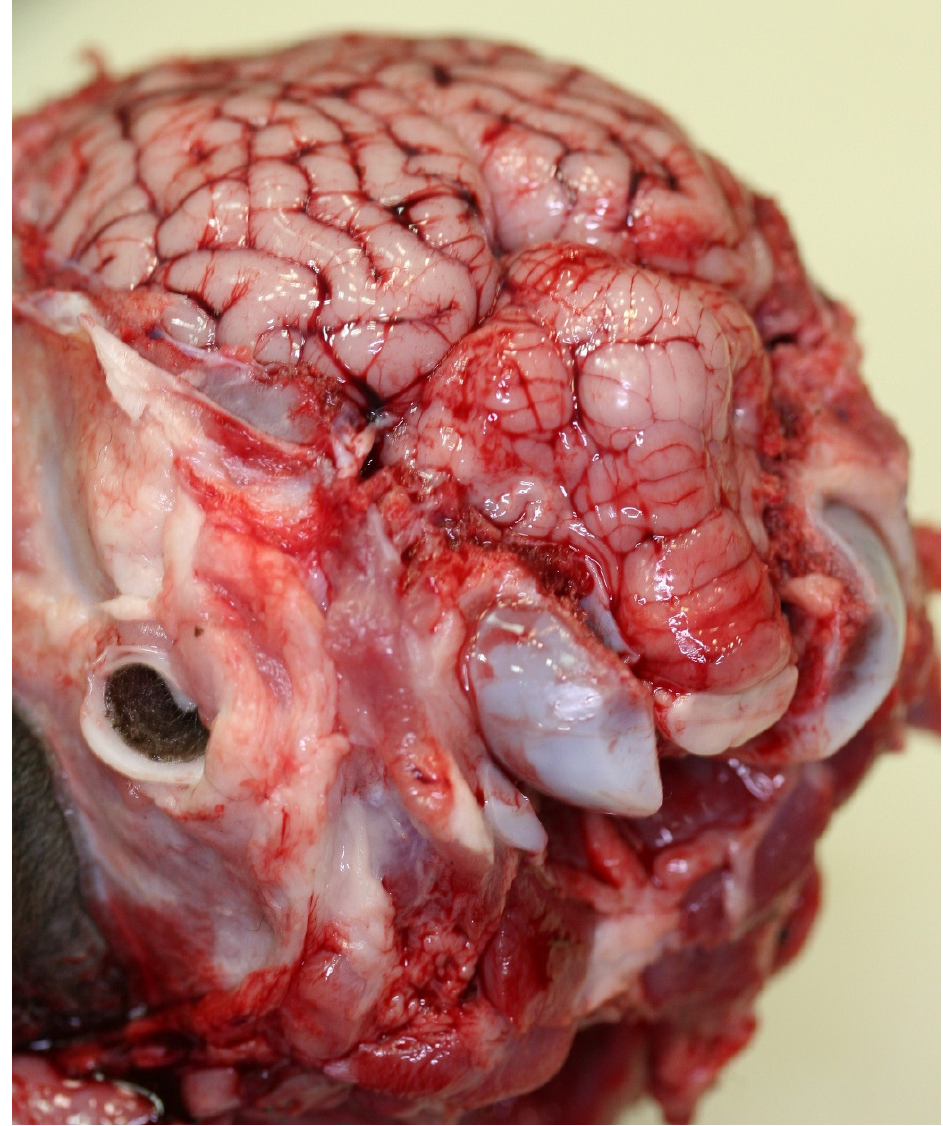
Figure 7. Herniation of the cerebellar vermis through the foramen magnum (“cerebellar coning”) in an ETX-intoxicated sheep. Photo courtesy of B. Barr.